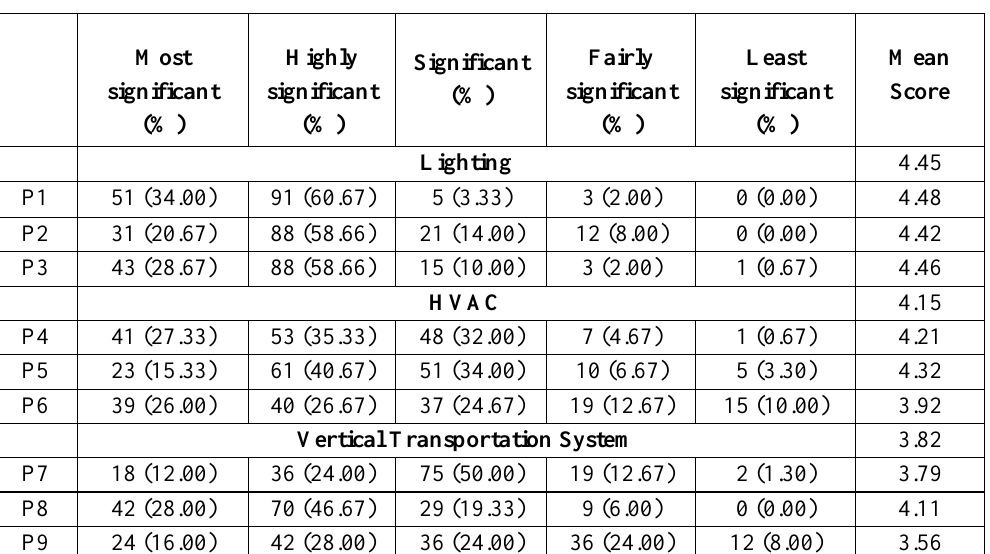
Table 2. Characteristics of Building Commissioning Practice (developed by the